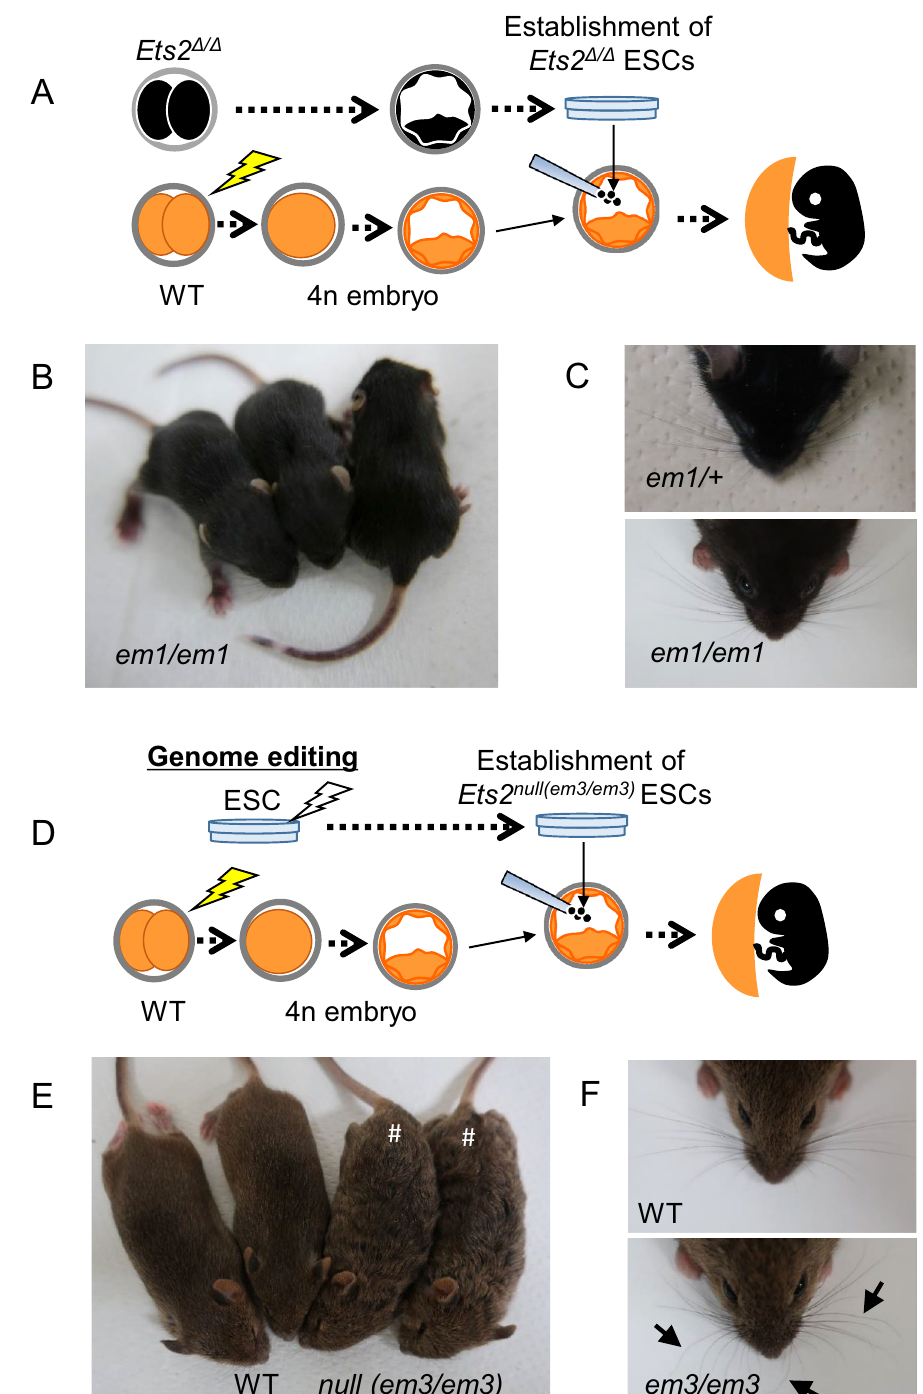
Figure 3. Generation of homozygous Ets2 mutant models using ESCs and assessment of hair and whisker phenotypes after birth. (A) Strategy for the generation of Ets2 homozygous mutant mouse after establishing the ESC from homozygous mutant blastocysts with tetraploid complementation. (B) 2-week-old Ets2 em1/em1 mice. (C) Faces of 4-week-old in Ets2 + /em1 (left picture) and Ets2 em1/em1 (right picture). Curly whiskers were not observed in Ets2 em1/em1 . (D) Strategy for the generation of Ets2 homozygous null mutant mouse after genome- editing to the ESC with tetraploid complementation. (E) The hair of the Ets2 null(em3/em3) mutant mouse was wavy (indicated as #). (F) Some whiskers of the null mutant mouse were not straight (arrow in the lower